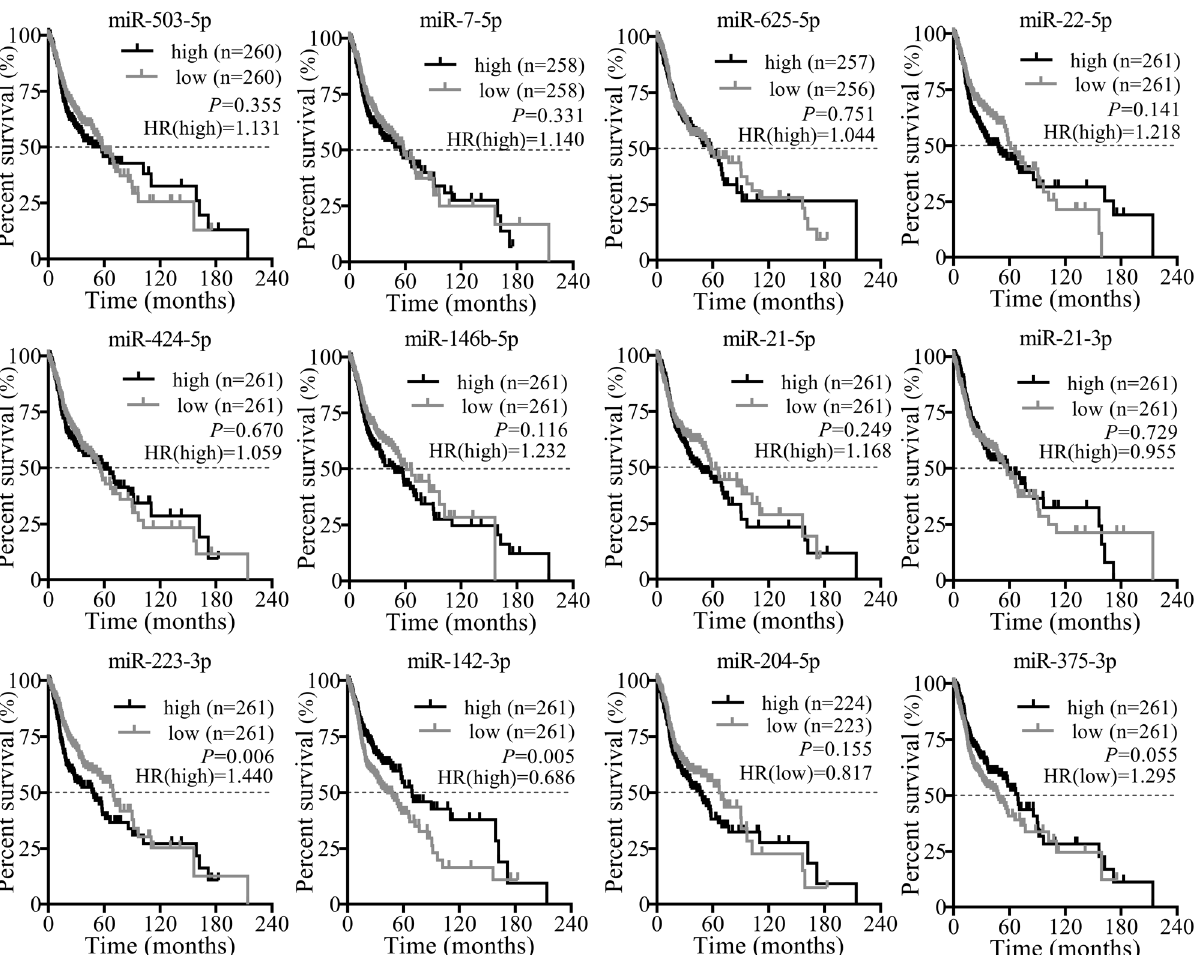
Figure 4: Overall survival analyses for di ff erential expressed miRNAs. X - axis represents the overall survival time and Y - axis represents the survival rates at di ff erent times. High means the miRNA expression levels were higher than the median of total miRNA expression levels, while low the opposite. HR: hazard ratio. HR ( high ) means the hazard ratio of high expression group to low expression group, while HR ( low ) the opposite. A value of p < 0.05 and HR > 0.5 mean signi fi cant di ff